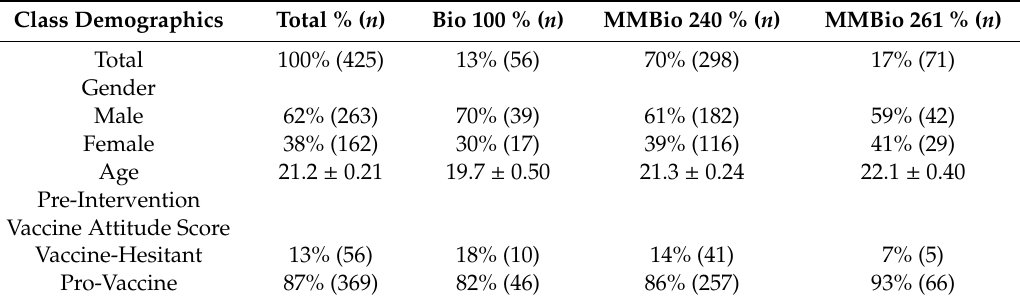
Table 1. Baseline characteristics of the participating classes ( n = 425).